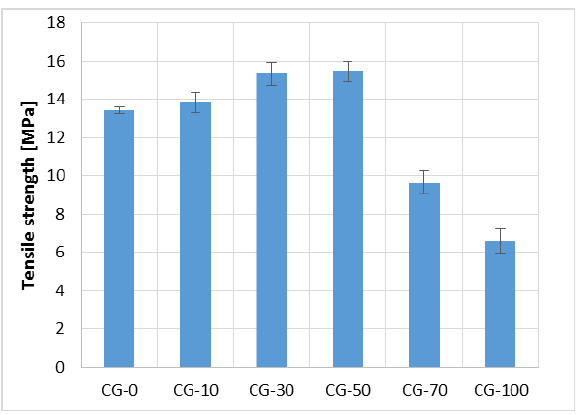
Figure 4. Tensile Strength of the Polymer Concretes (in the form of error bars, the standard deviation is shown).